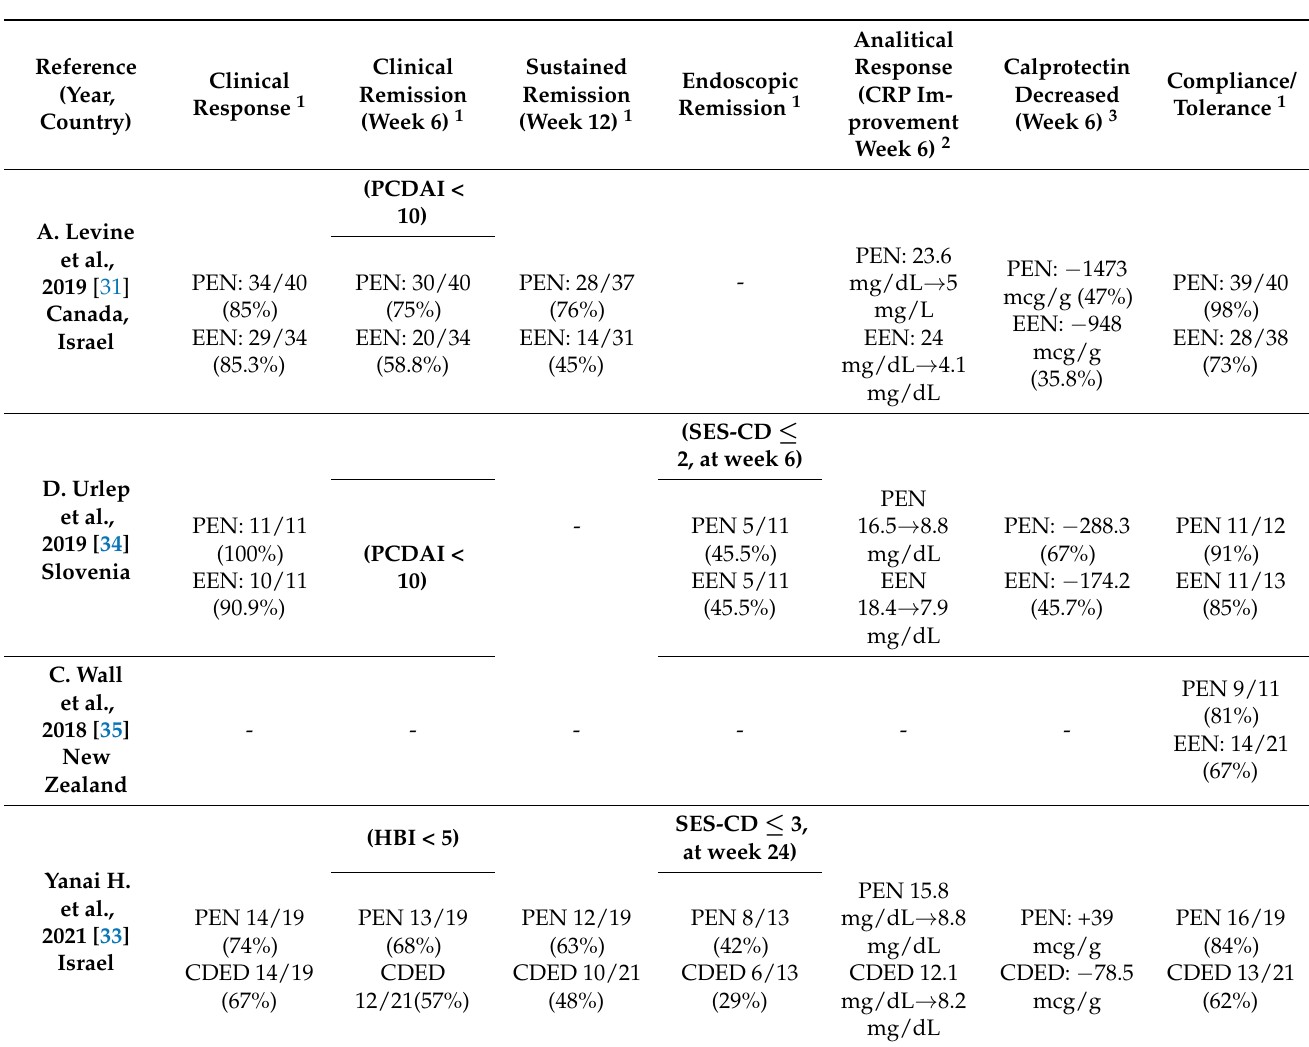
Table 4. Efficacy of partial enteral nutrition (PEN) in 175 patients with Crohn’s disease in randomized controlled